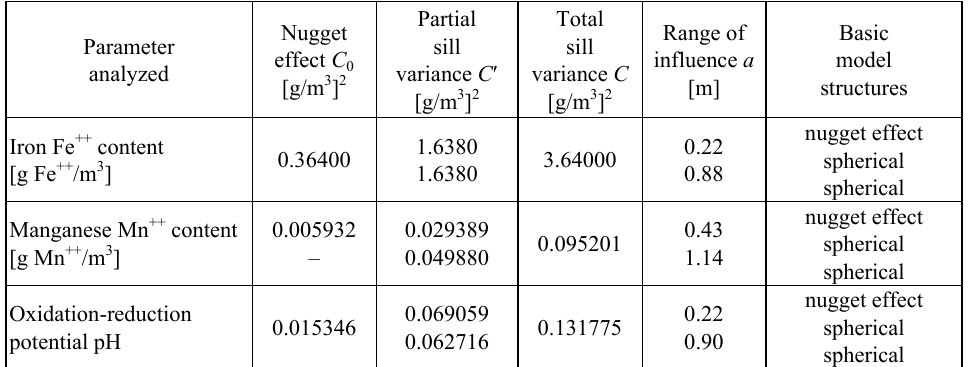
Table 9. Comparison of values of geostatistical models of directional semivariograms D-90 of quality parameters of underground water in area of water intake in the region of